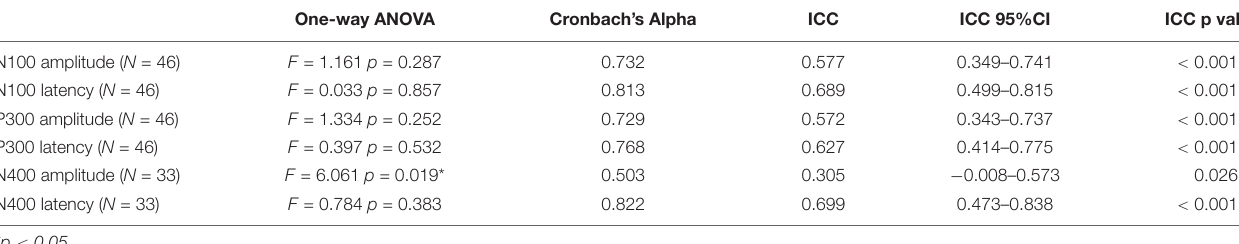
TABLE 4 | Statistical analysis for Test-Retest reliability of brain vital signs in Group A. One-way ANOVA Cronbach’s Alpha